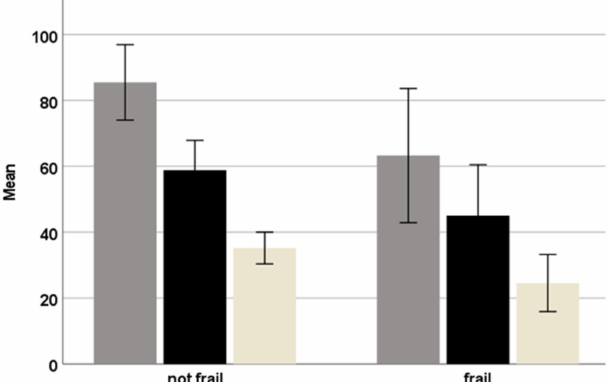
Figure 1. Participation; differences between ‘frail’ (N = 39) and ‘non-frail’ (N = 80) older adults in the mean (SD) RNL-I total (grey) and sub-scores: participation in physical activities (off-white) and participation in social events (black). Please note: the RNLI- total score ranges from 0 to 100 points, participation in physical activities from 4 to 40 points, and participation in social events from 7 to 70